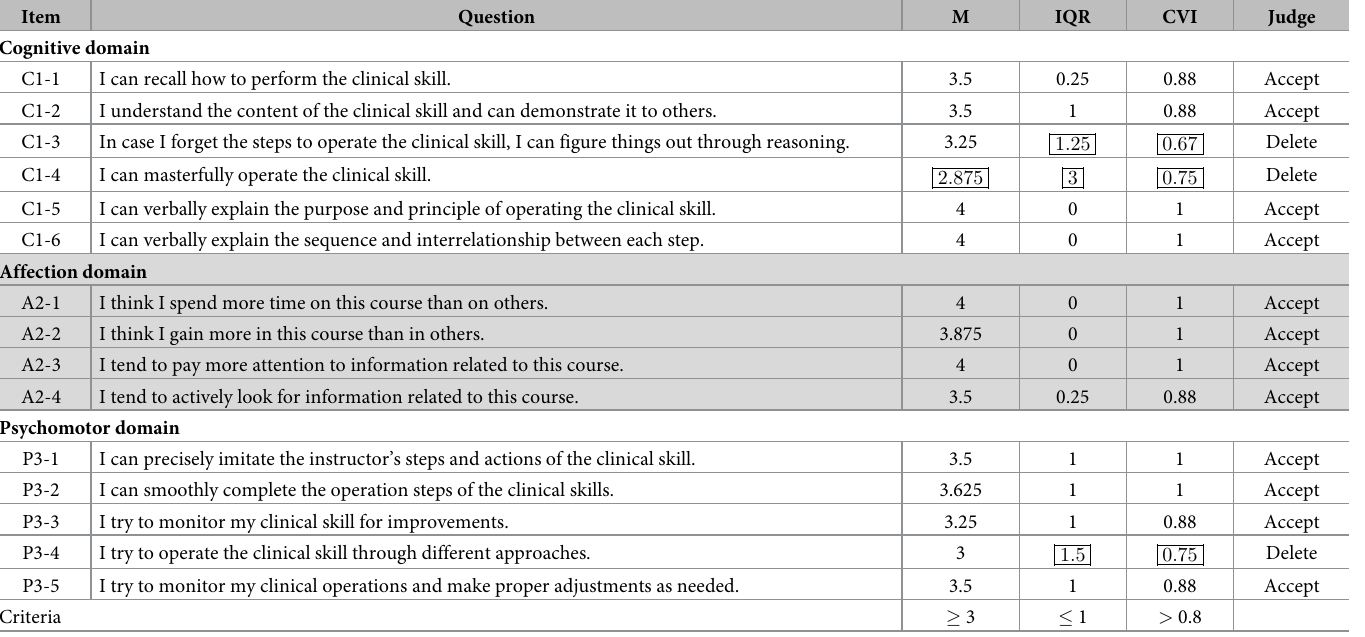
Table 1. Expert content validity index values of 12 questions in the